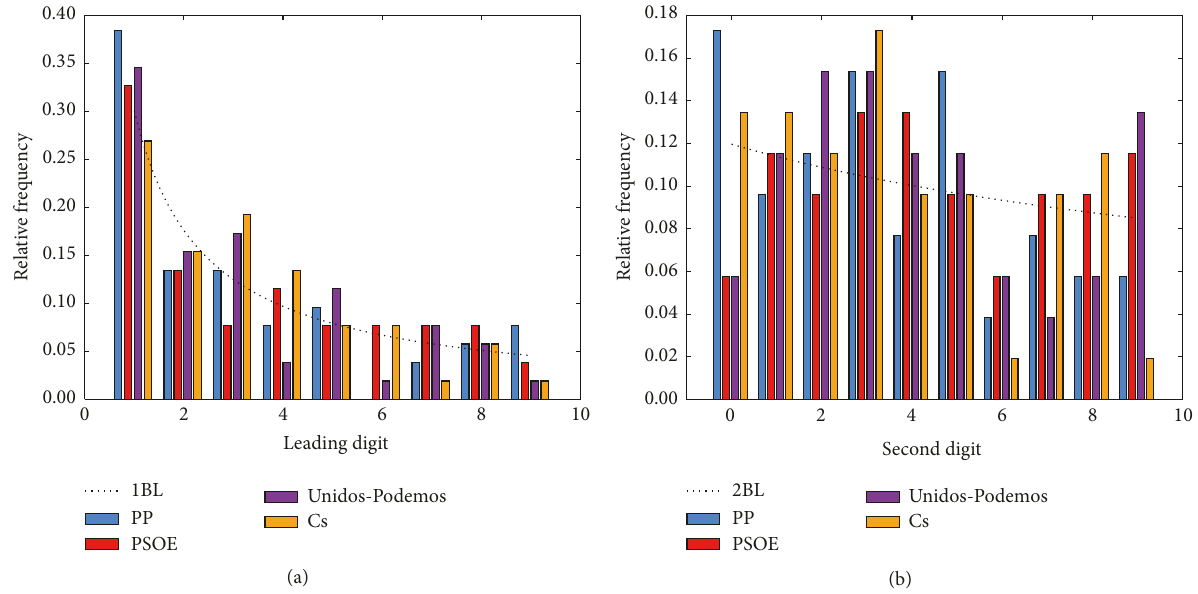
Figure 14: Histograms of relative frequencies for the first (a) and second (b) significant digits for the main political parties vote counts aggregated over precincts, for the case of 2016 (2015 is shown in Figure 15).